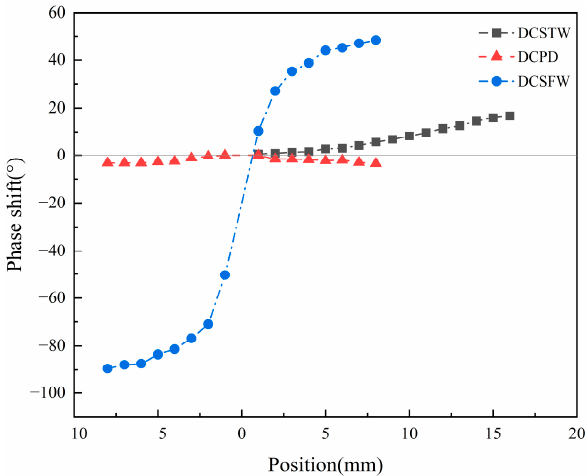
Figure 15. Phase shift of the output signal of the AD630 circuit. The output signal of the AD630 circuit is filtered by a low-pass filter, and the final DC voltage signal is output. The simulation results are shown in Figure 16.